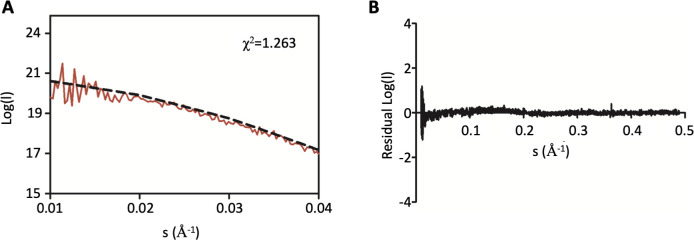
Additional SAXS analysis of DolP.(A) Zoom in of the low s region of the small-angle X-ray scattering curve of DolP shown in Figure 2 highlighting the closeness of fit to the DolP solution structure. (B) Residuals plot between the DolP solution structure and the small-angle X-ray scattering curve highlighting the closeness of fit.